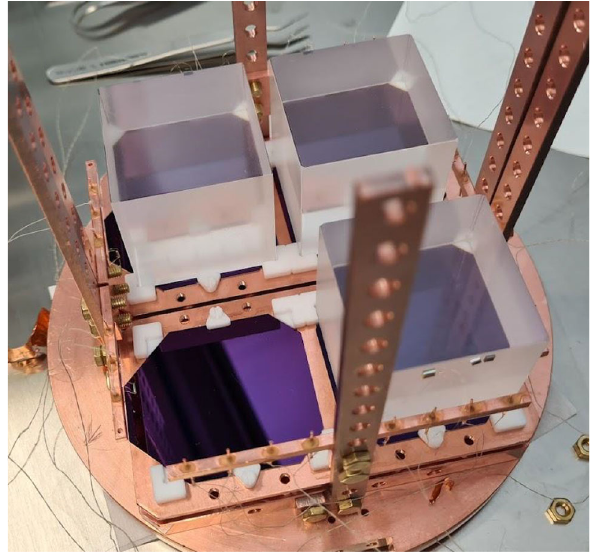
Fig. 2 Photoofthearrayduringthedecommissioning. Hereareshown 2 baseline modules of CUPID, which form the first floors of the 2 mini- towers. In one of the 2 modules an LMO crystal is missing and a quasi- square LD is visible on the bottom